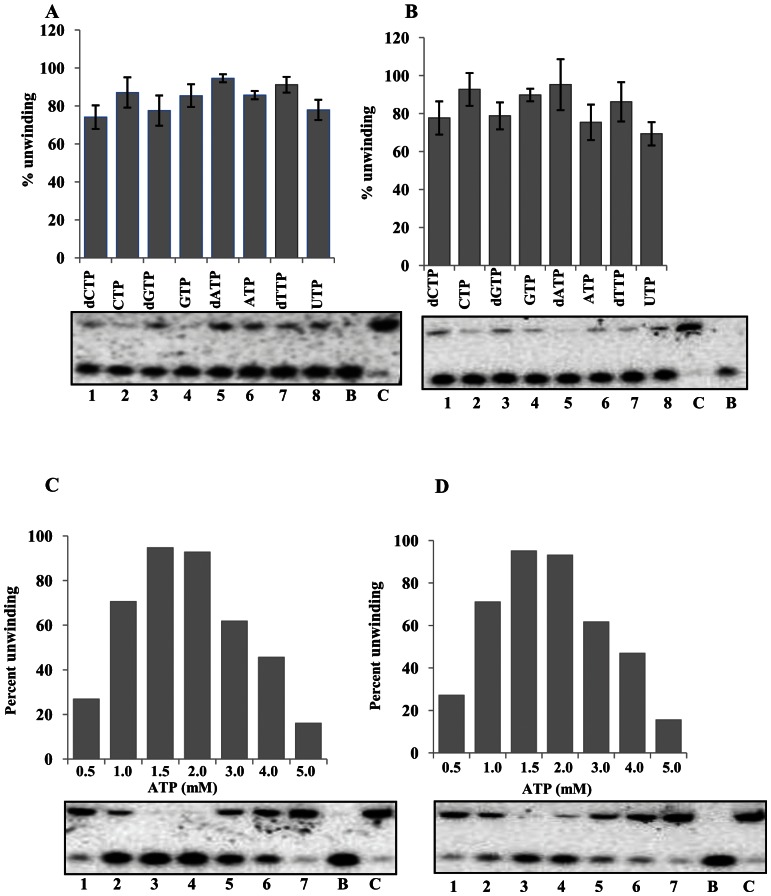
Determination of nucleotide-dependence of helicase activity.A–B. Nucleotide requirement of helicase activity of sUD (A) and sUDN1N2 (B). Helicase activity of sUD and sUDN1N2 in the presence of NTP/dNTPs written on top of the gel. Lane C is enzyme reaction in the absence of any NTP or dNTP and B is heat denatured substrates. C–D. Helicase activity of sUD (C) and sUDN1N2 (D) using varying concentration of ATP written on top of the gel. Lane C is enzyme reaction without any ATP and B is heat denatured substrate. In panel A–D, the quantitative enzyme activity data from the autoradiogram are shown.